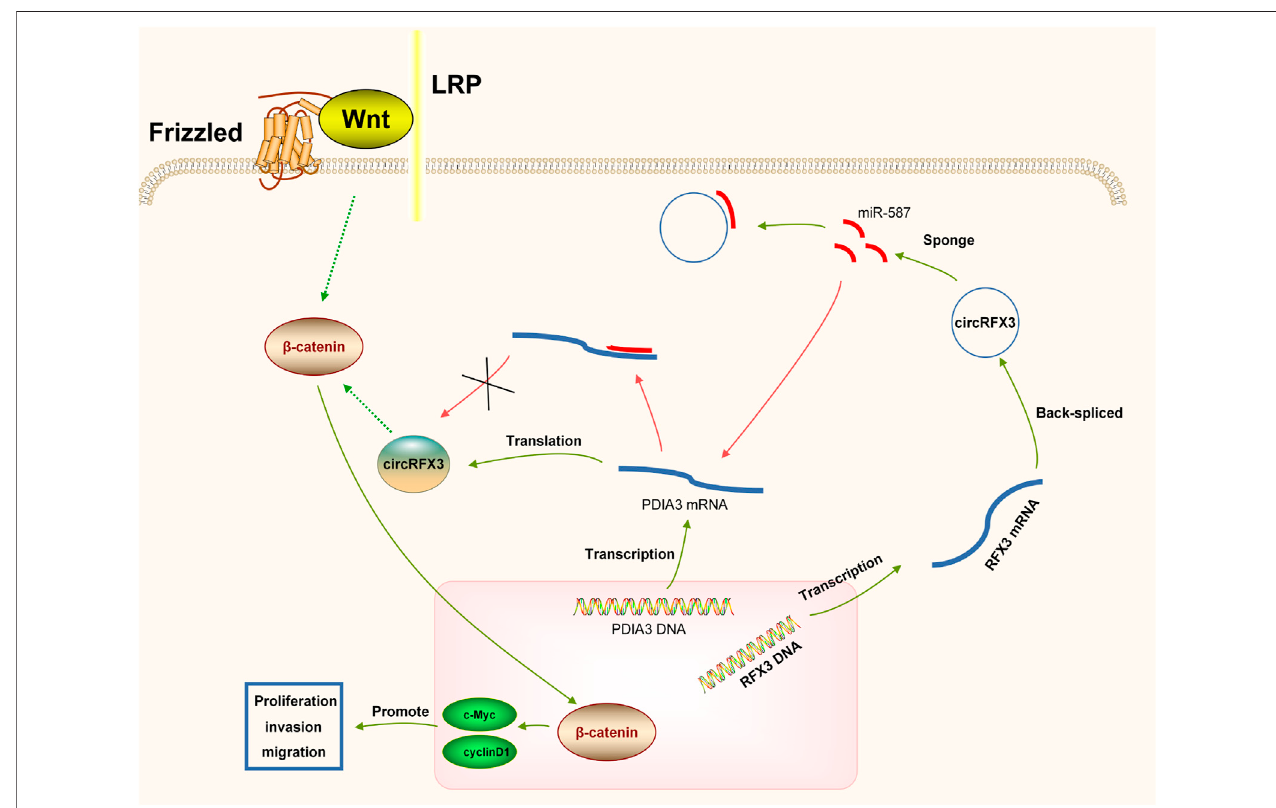
FIGURE 8 | circRFX3 could act as a cancer-promoting circRNA to boost the development of glioblastoma and regulate the miR-587/PDIA3/ β -catenin axis.